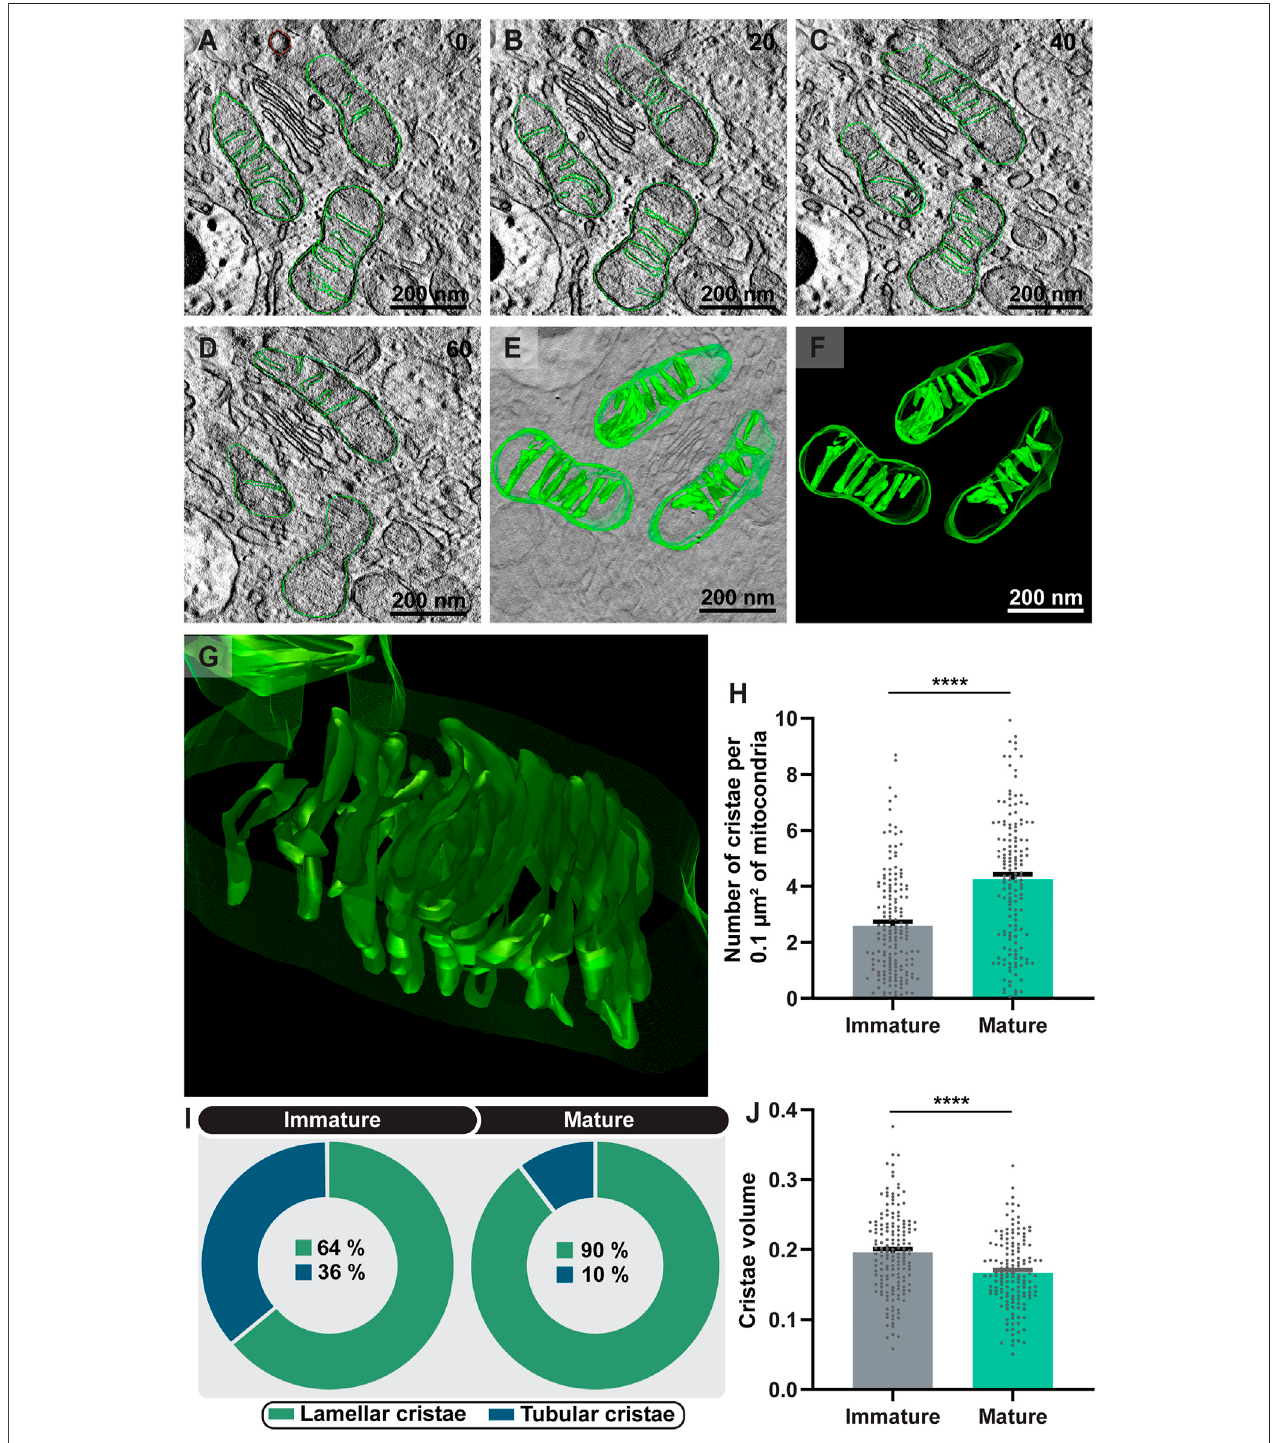
FIGURE 6 | Eosinophilopoiesis leads to increased formation of mitochondrial cristae and cristae remodeling. (A – G) Representative 4 nm-digital slices of a tomogram showing mitochondria with lamellar cristae, the most common shape of cristae found within developing mouse eosinophils. Mitochondria boundaries and internalmembranesinconsecutivetomogramslicesweremanuallycontouredingreenandcomputer-based3Dmodelsweregenerated (F) .In (G) ,theaspectoflamellar cristae is shown in higher magni fi cation. Virtual slices were extracted from 3D reconstructions of a 200 nm eosinophil section analyzed by fully automated electron tomography at 200 kV. The numbers on the upper right corner indicate the slice number through the tomographic volume. Both the total number of cristae (H) and the